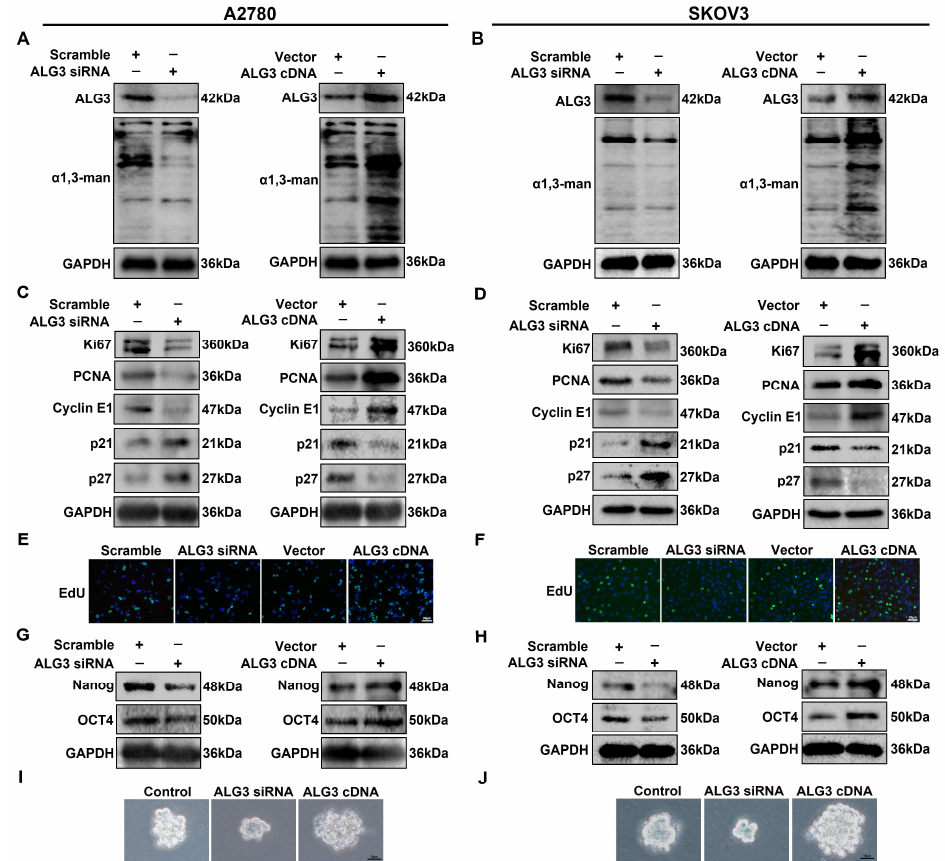
Figure 3. ALG3 promotes cancer stemness and proliferation in ovarian cancer cells. ( A , B ) Western blot analysis of ALG3 expression and Lectin blot analysis of α 1,3-mannosylation in A2780 ( A ) and SKOV3 ( B ) cells after transfection with scramble siRNA, ALG3 siRNA, vector and ALG3 cDNA. ( C , D ) Western blot detected changes in Ki67, PCNA, cyclin E1, p21 and p27 in A2780 ( C ) and SKOV3 ( D ) cells. ( E , F ) EdU assay of cell proliferation ability. ( G , H ) Western blot analysis of Nanog and OCT4 expression. ( I , J ) Representative microscopy image of sphere formation assay in A2780 ( I ) and SKOV3 ( J ) cells. The bar represents 20 μm ( E , F ) or 10 μm ( I , J ).